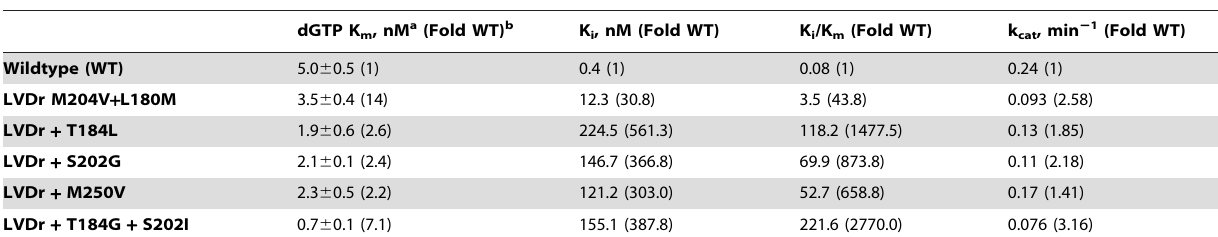
Table 2. Kinetic Parameters for HBV Polymerases.